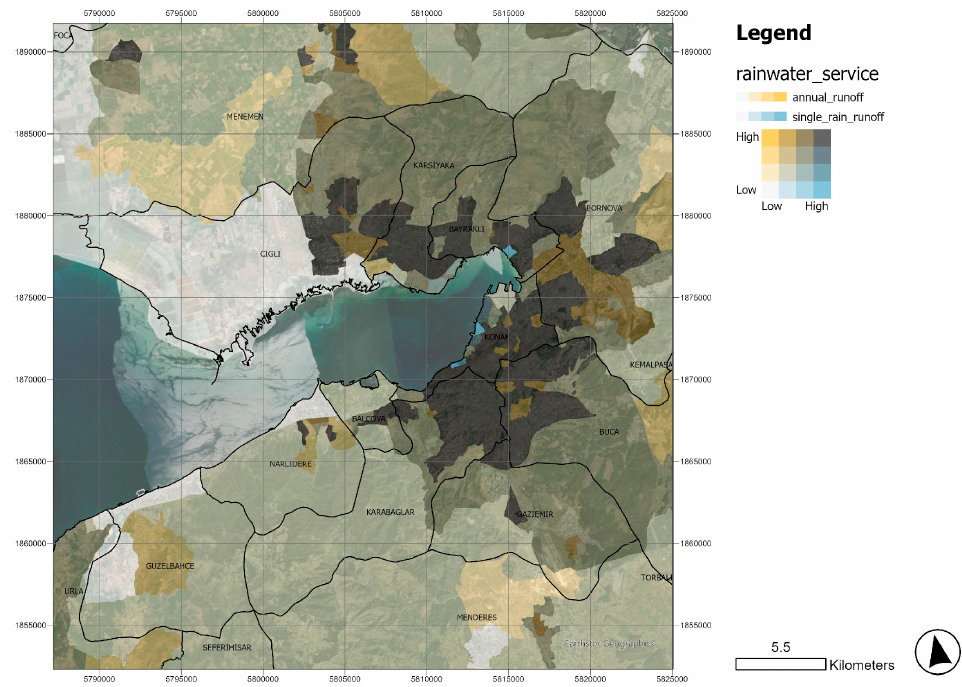
Figure 4. Map integration. flood risk mitigation and stormwater management performance. Source: author’s elaboration on InVEST output.